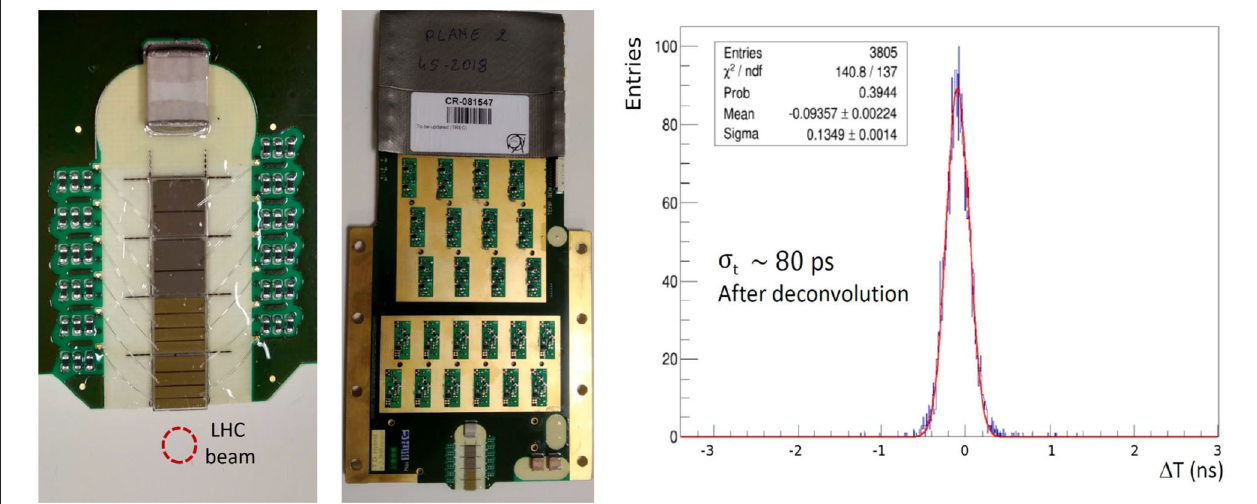
FIGURE 9 | On the left, there is a closeup picture of the crystals were sensor segmentation and bonding wires are visible. On the center, the full detector board is shown. On the right, the measured time difference between a small pad (0.29 pF) and a big pad (2.0 pF) located in two consecutive layers is shown. After the deconvolution of the contribution of the time reference, 80 ps precision on one of the small pads is obtained. Adapted from [ 53] under the Creative Commons CC BY license.